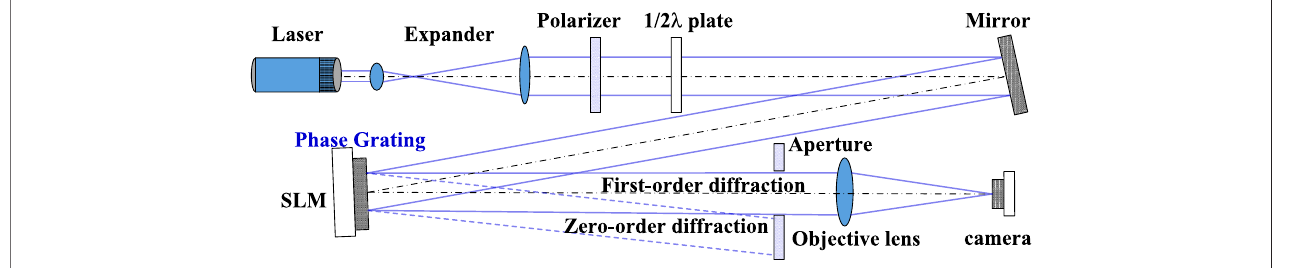
FIGURE 1 | Schematic setup for beam shaping.